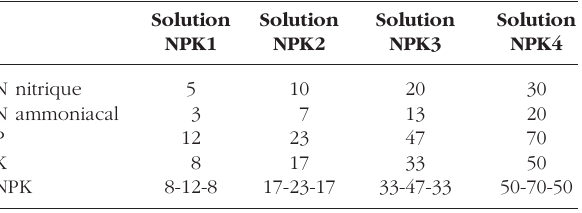
Table I. – Concentrations (en mg/l) d’azote (N) nitrique (NO 3– ), d’azote (N) ammoniacal (NH 4+ ), de phosphore (P) sous la forme d’anhydride phosphorique (P O ) et de potassium sous la forme 2 5 d’oxyde de potassium (K O), pour chacune des solutions NPK tes- 2 tées sur Aedes aegypti